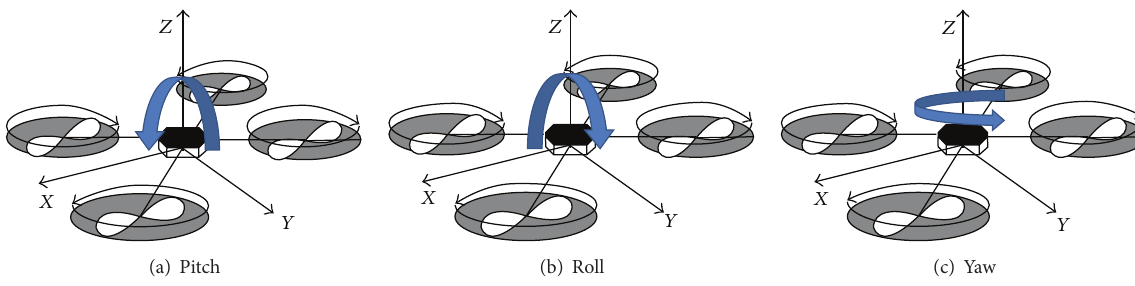
Figure 1: Three basic movements of quad-rotor